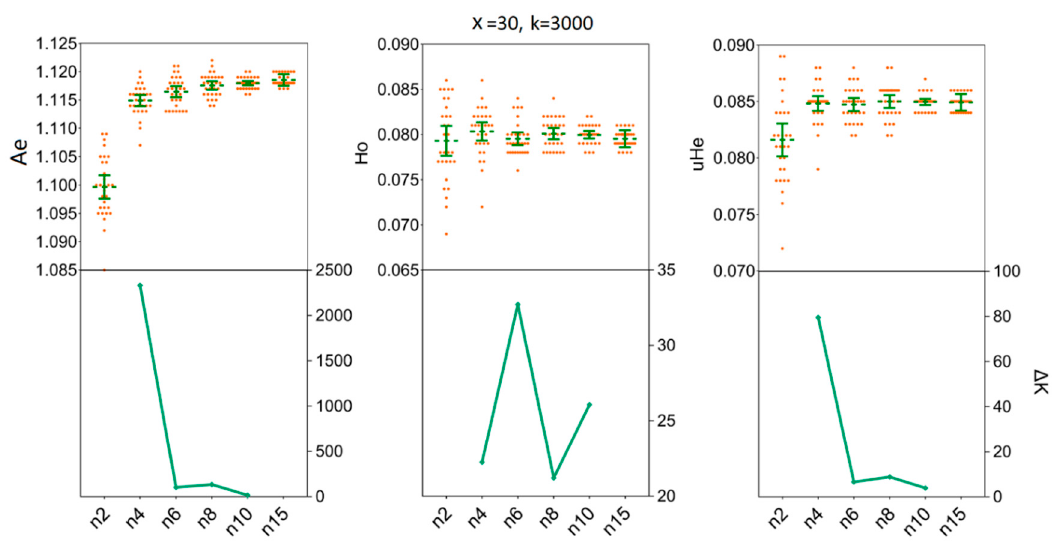
Figure 6. The minimum sample size ( n ) required to estimate the genetic diversity in PLKK population. Bars represent sample means and 95% confidence intervals of the means. The ∆ K ( Y -axis) shows a clear peak at the minimum sample sizes ( n ). Ae , number of effective alleles; Ho , observed heterozygosity; uHe , unbiased expected heterozygosity.